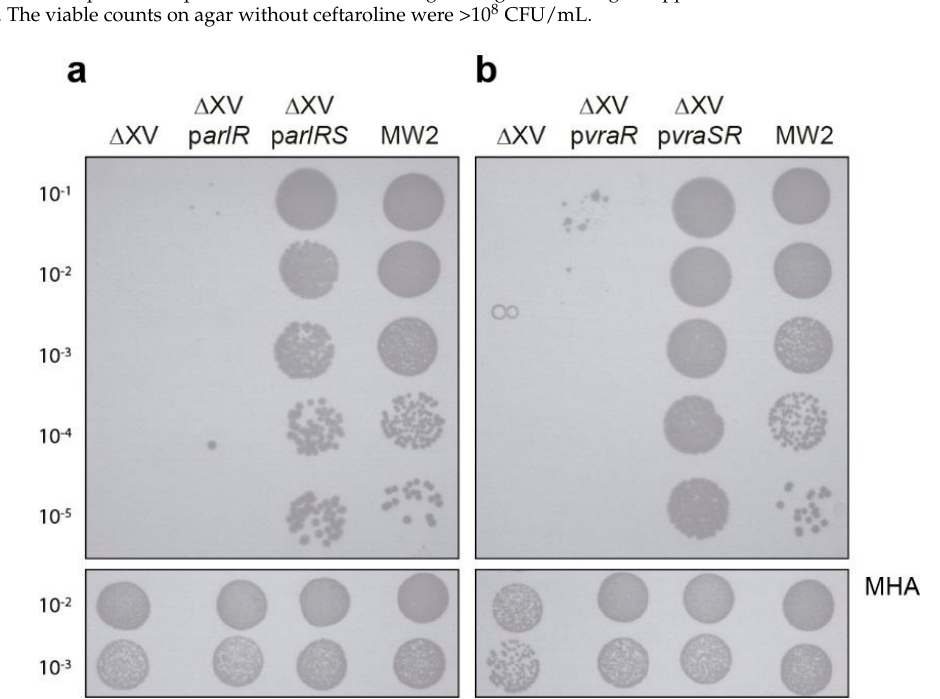
Figure 3. ( a ) arl and ( b ) vra histidine kinases are necessary for ceftaroline response. Spot plating population analysis profiles (Spot PAP) of MW2, ∆ XV, and ∆ XV strain complemented with arl and vra response regulators alone or the complete TCS, on MHA plates containing ceftaroline at 48 h. The upper panel corresponds to MHA plates containing 0.25 µ g/mL of ceftaroline. The lower panel corresponds to MHA plates without ceftaroline. Spot serial 10-fold dilutions are indicated at the left margin. The first spot (10 µ L) corresponds to 1.5 × 10 5 colony forming units (CFU). To determine whether the hypersensitivity to ceftaroline in the double mutant arlRS / vraSR strain observed on agar plate assay was demonstrable in a broth assay, we performed early time-kill experiments. We tested the response of MW2, and its single or double mutant derivatives: ∆ arlRS , ∆ vraSR , and ∆ arlRS / ∆ vraSR, to challenge with ceftaroline in a concentration range 0.25 µ g/mL to 1 µ g/mL (1/2 MIC, MIC, and 2 × MIC). Aliquots were removed over a three-hour interval, serially diluted, and spotted on MHA plates